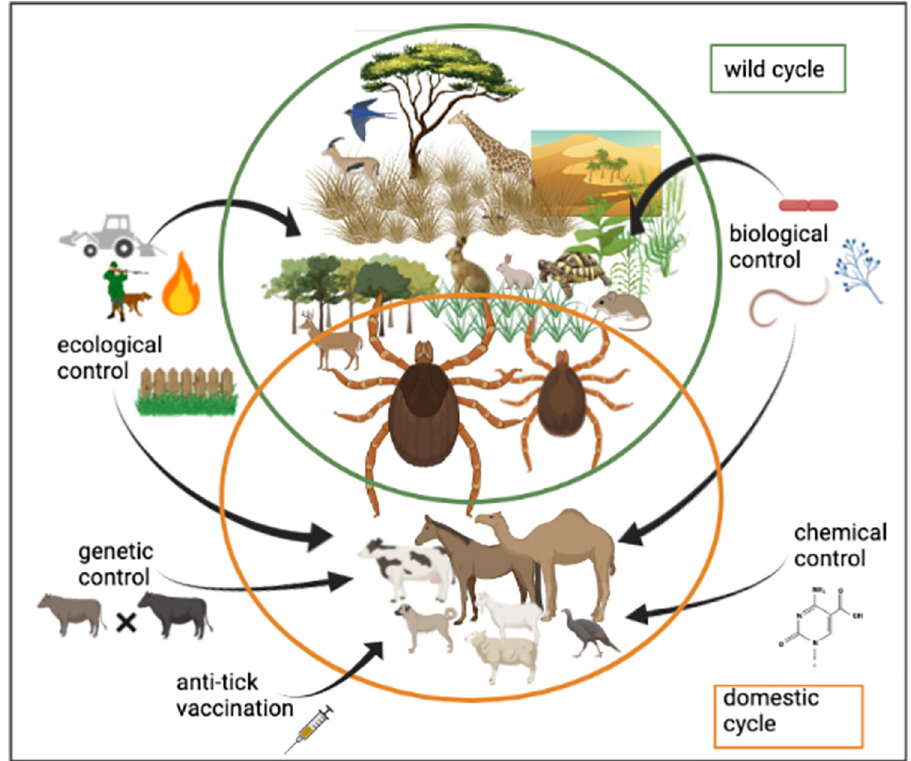
Fig 2. Schematic representation of the different control methods applicable to Hyalomma ticks for consideration in the context of integrated pest management. Created with BioRender.com.